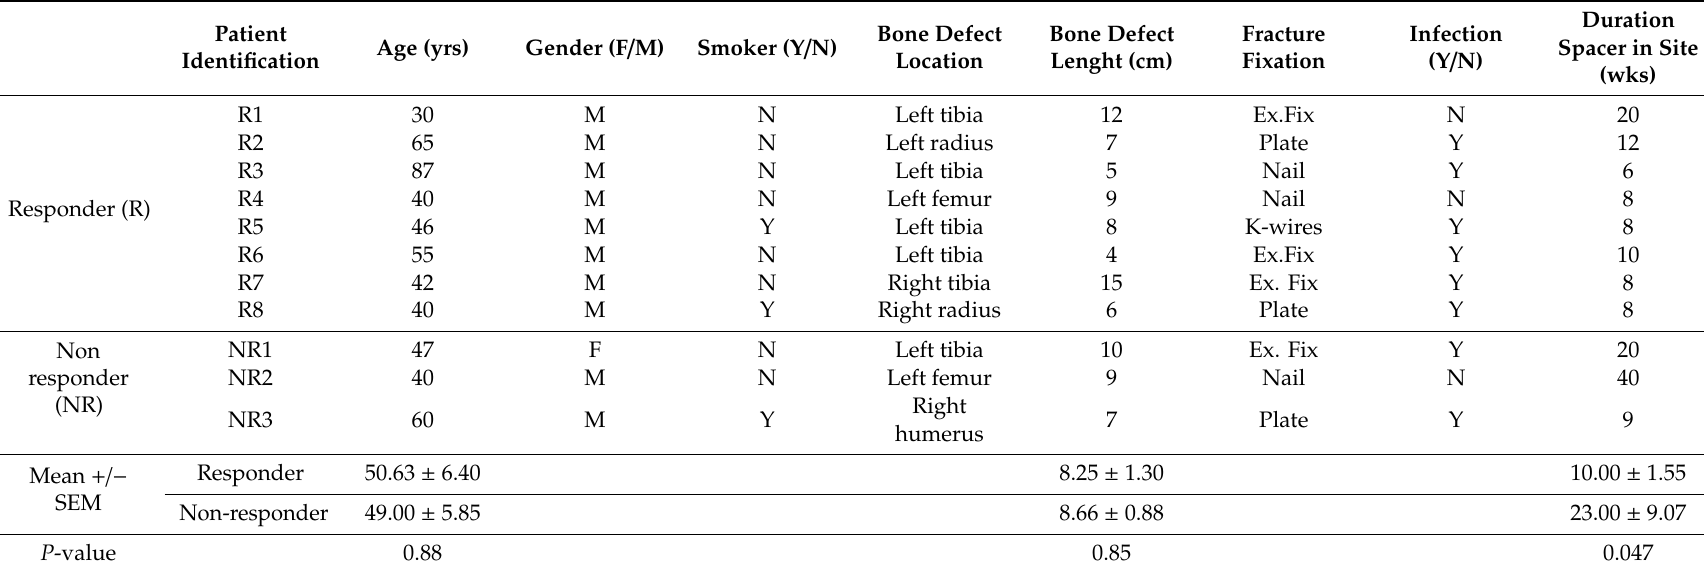
Table 1. Demographic and clinical characteristics of